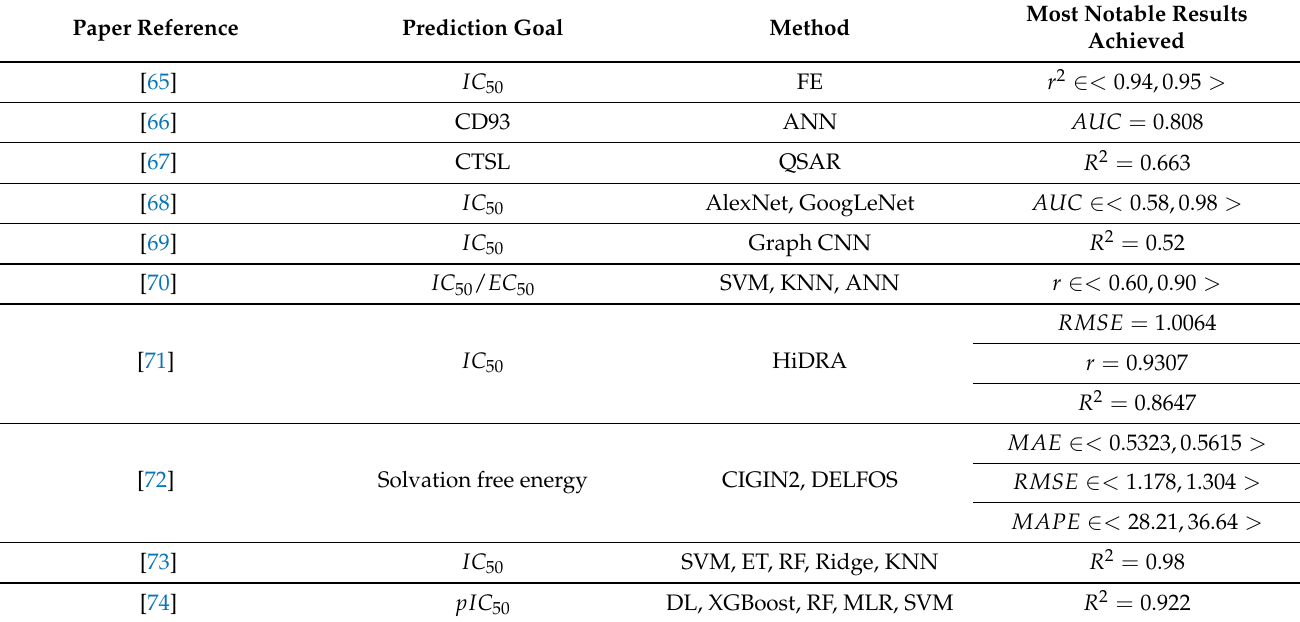
Table 2. Overview of the state-of-the-art research published in the field in the last two